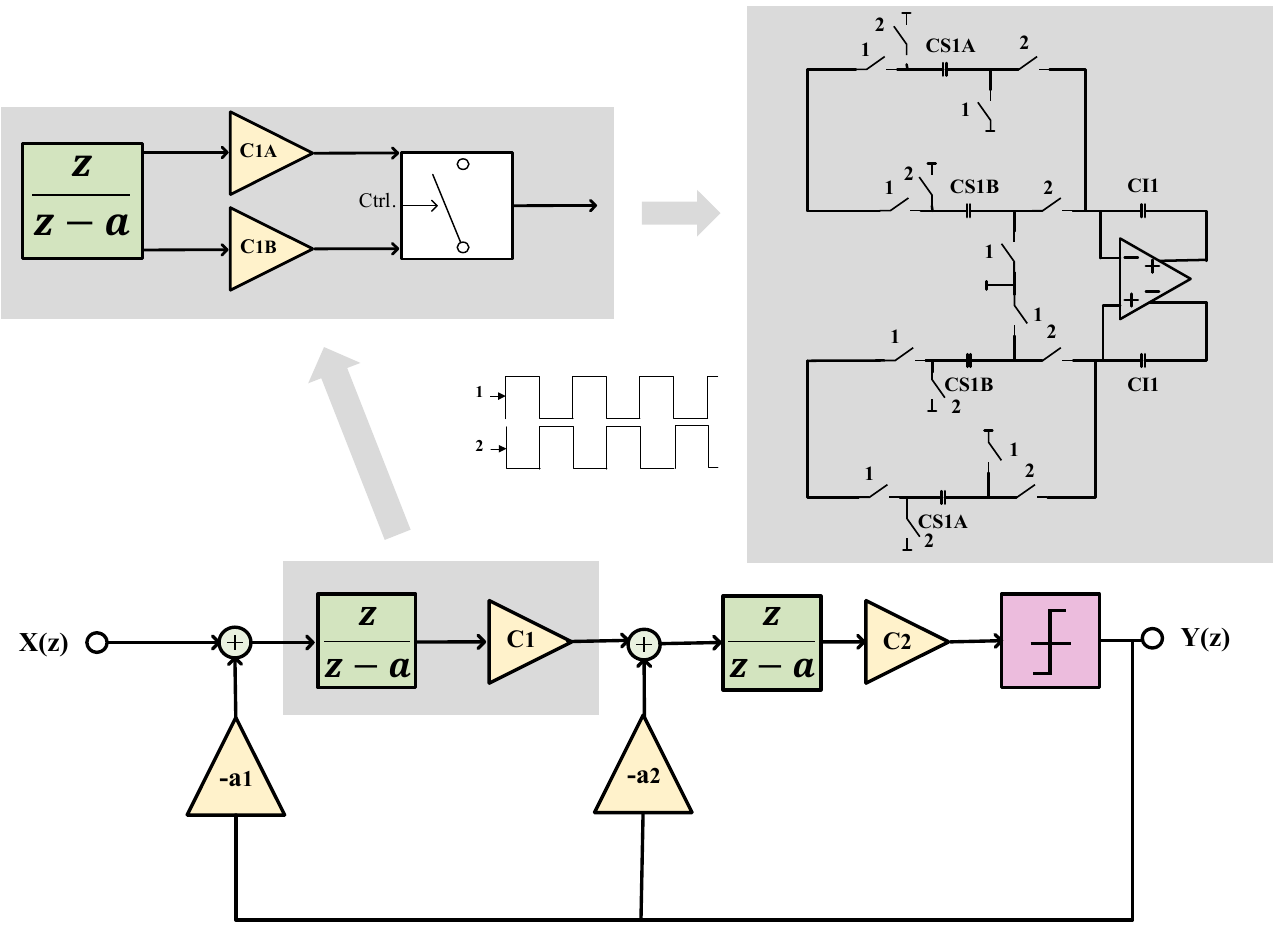
Figure 2. System level of the proposed double sampling CIFB modulator.